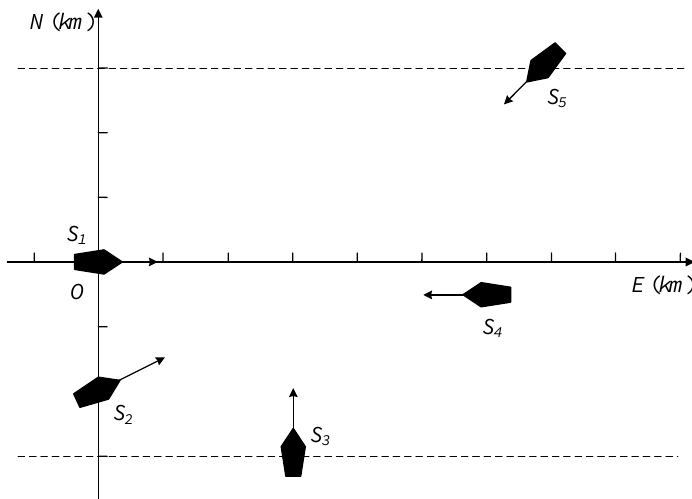
Figure 8. Scenario verification diagram.